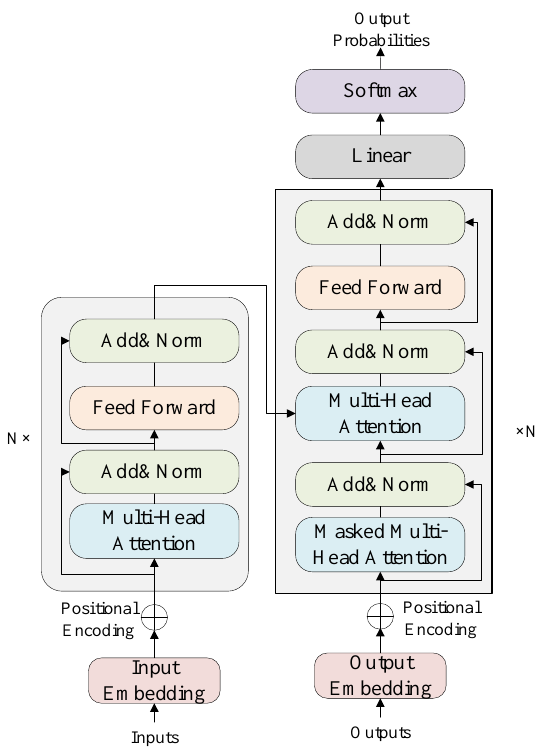
Figure 3. The architecture of transformer.